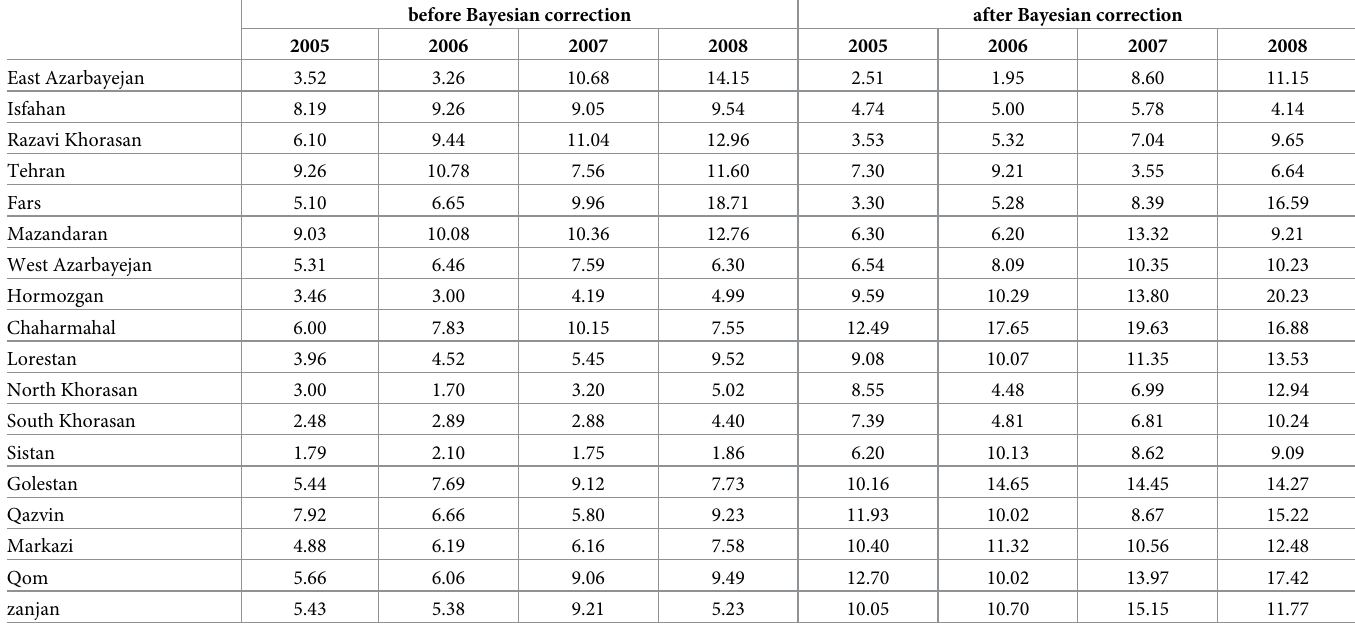
Table 3. Age standardized rate of colorectal cancer incidence before and after Bayesian correction in Iranian provinces 2005–2008. before Bayesian correction after Bayesian correction